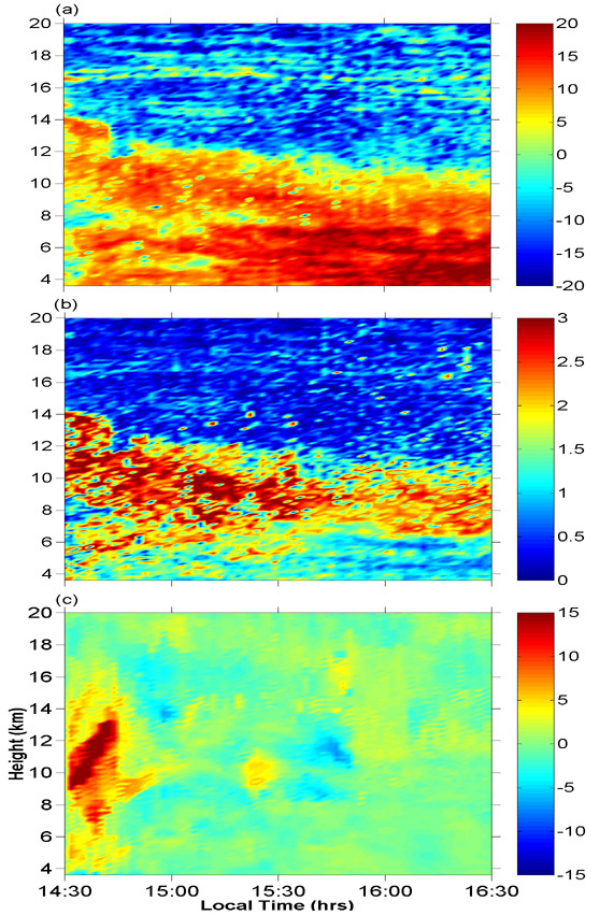
Fig. 5. Height-time sections of (a) VHF radar signal-to-noise ratio (dB), (b) spectral width (m/s) and (c) vertical velocity (m/s) for a single-cell convective system ,as observed on 25 May 2002.